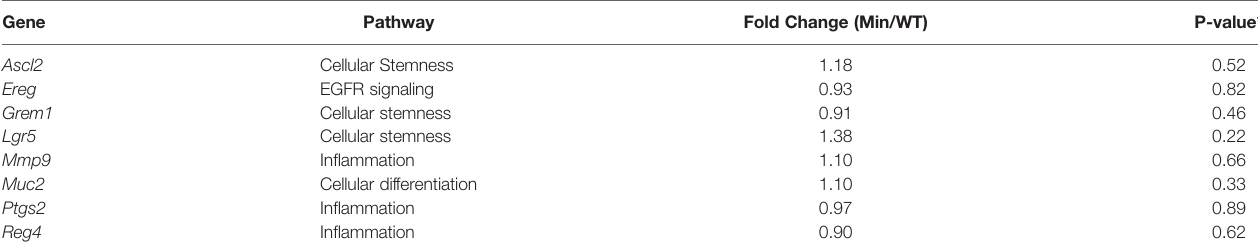
TABLE 1 | Fold change in mean gene transcription in the initiated colonic mucosa of Apc +/Min-FCCC (Min) vs wild type (WT) mice after removing outliers. Gene Pathway Fold Change (Min/WT) P-value* Ascl2 Cellular